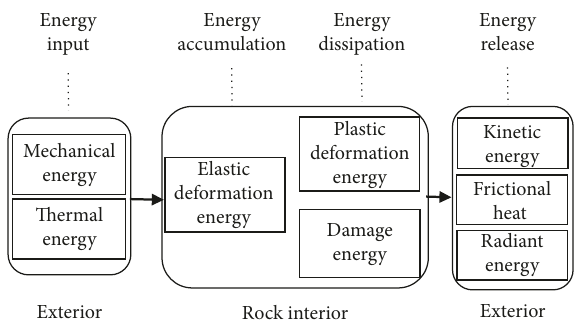
Figure 8: Energy conversion processes of the rock being